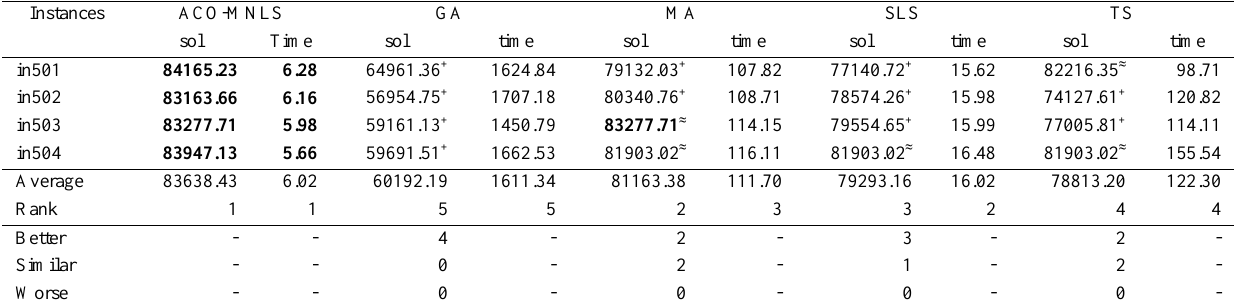
Table 5. Experimental results of proposed ACO-MNLS, GA, MA, SLS, and TS on some instances of REL-1500-1000.